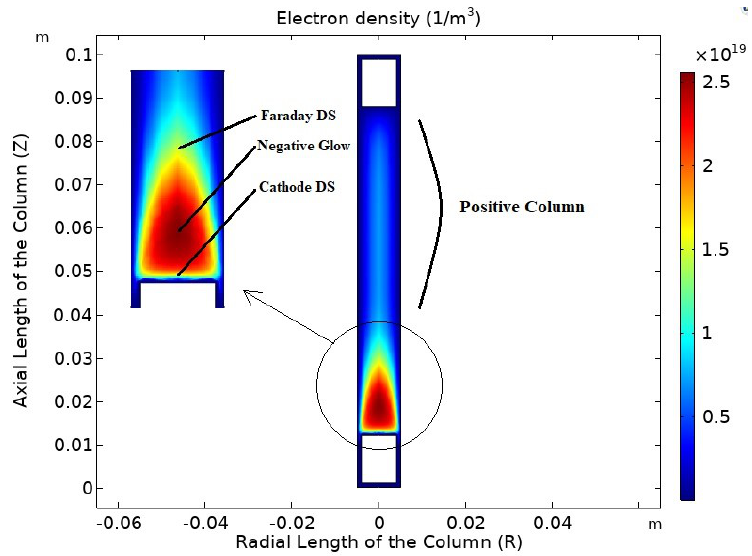
Figure 6. Visualization of plasma column at 500 V.